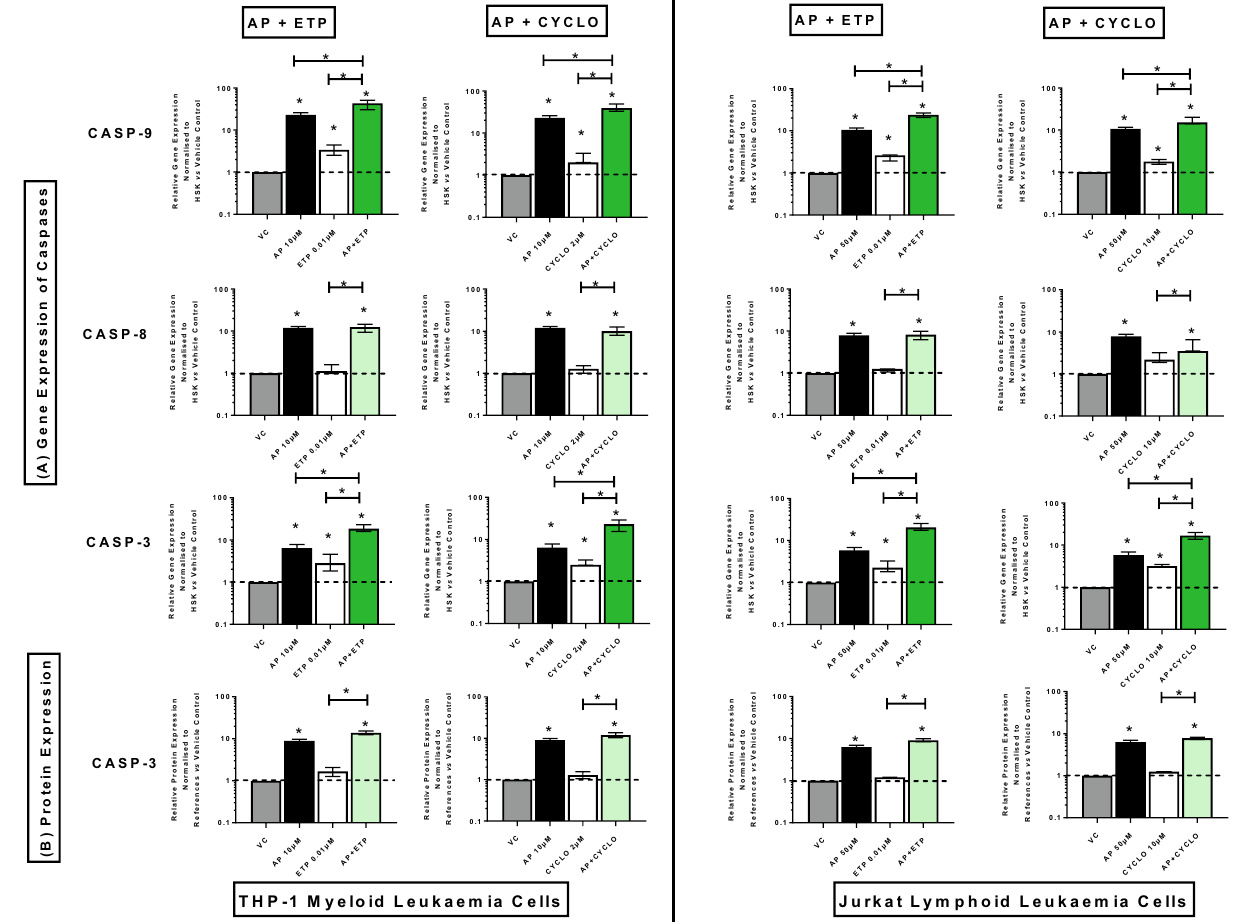
Figure 7. Effects of apigenin (AP) alone and in combination with etoposide (ETP) and cyclophosphamide (CYCLO) on expression of caspase genes ( A ) and proteins ( B ) in acute myeloid (THP-1) and lymphoid (Jurkat) leukaemia cell lines when treated with their lowest significant doses (LSDs) that induce apoptosis (determined previously in Mahbub et al. 2013, 2015, 2019) for 24 h. Gene and protein data are expressed as medians and ranges. Results were considered statistically significant when P ≤ 0.05 (*). The combination treatment effects and colours were determined based on the statistical analysis as described